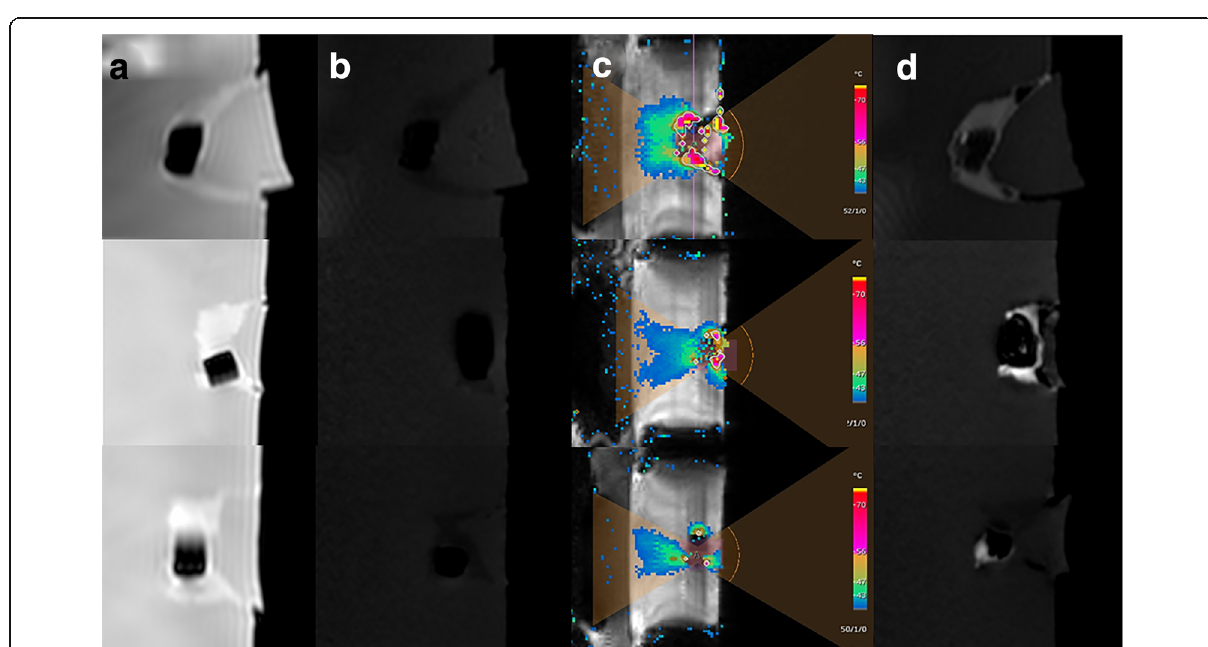
Fig. 5 1.5-T MRI-tracked HIFU-triggered release of three wax-coated capsules ( n = 3, separate experiments shown on three different layers). The position of the wax-coated capsule prior to the application of the HIFU pulse was determined using a 3D T2-weighted turbo spin echo sequence (repetition time 1000 ms, echo time 130 ms, a ). The intact wax-coated capsule showed no hyperintensity on a 3D T1-weighted fast field echo sequence (repetition time 6.75ms, echo time 3.3ms, flip angle 10°), demonstrating that the non-hydrated lyophilised GBCA is not T1-hyperintense ( b ). T2-weighted MRI was used for guidance of the HIFU pulse and MR thermometry (colour mapping reveals thermal exposure, c ). After the highly localised application of a 200-W HIFU pulse, a distinct T1-hyperintense signal was observed ( d ) using the same sequence as in b . The local temperature increase most probably melted the wax coating, allowing water to penetrate the capsule core and hydrate the encapsulated lyophilised GBCA, and thus resulting in the T1-hyperintensity. Hyperintensity varies depending also on the dissolution kinetics of the GBCA in the surrounding water, the amount of surrounding medium, and the imaging delay after HIFU-induced disintegration. GBCA: Gadolinium-based